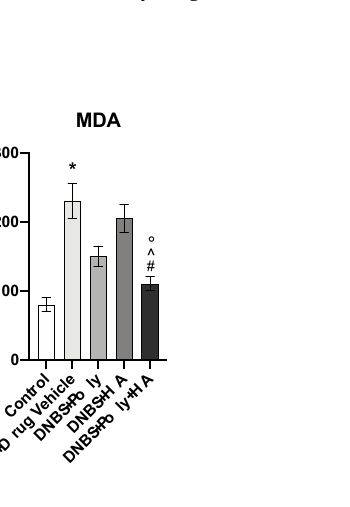
Figure 8. The e ff ects of treatments on malondialdehyde levels and myeloperoxidase activity in DNBS-treated animals are shown in ( A , B ). All values are expressed as means and SD based on observations made on 10 animals per group. * p < 0.0001 vs. control group; # p < 0.0001 vs. DNBS + Drug vehicle group; ° p < 0.001 vs. DNBS + HA; ^ p < 0.001 vs. DNBS + Poly.